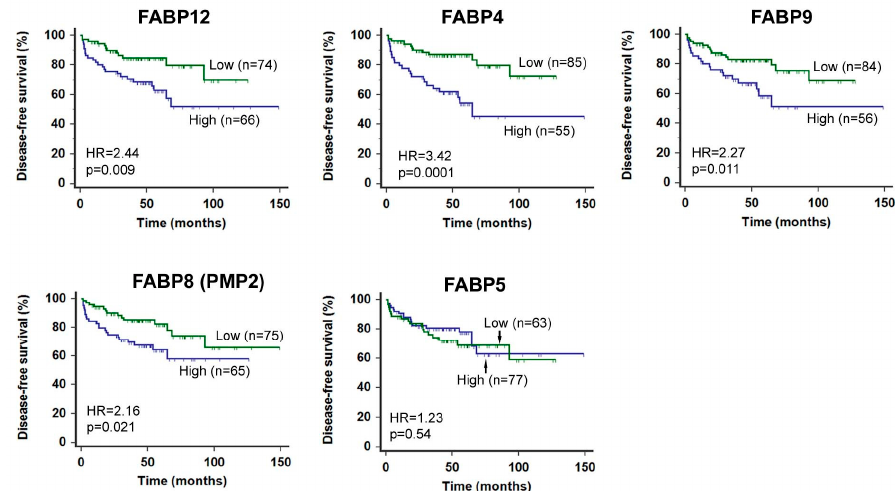
Figure 2. Human PCa disease-free (DF) patient survival analysis based on mRNA levels of each FABP